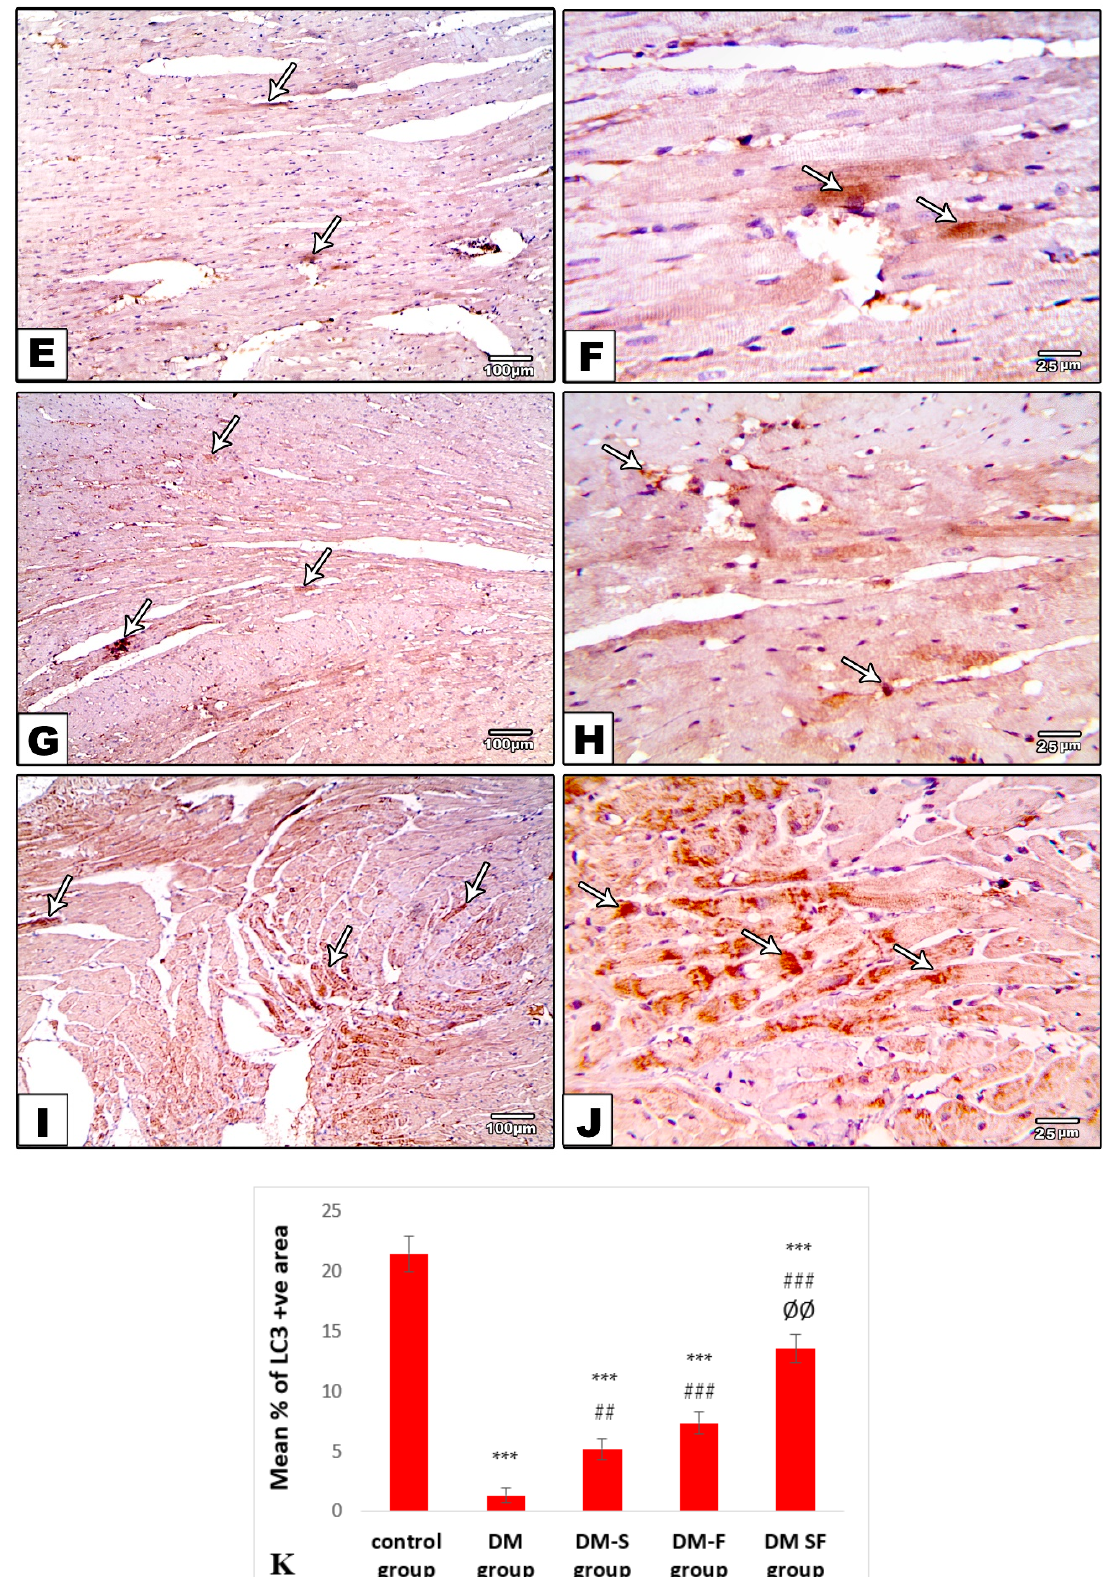
Figure 6. ( A – J ) shows the immunohistochemical staining for LC3 in different groups. ( A , B ) Strong positive brown reaction in the control group(arrows), ( C , D ) in contrast, the positive brown